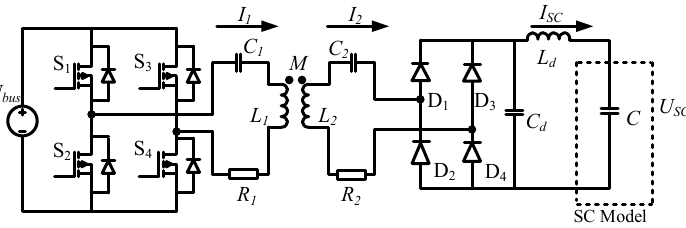
Figure 2. Topology of SC-load WPT system.